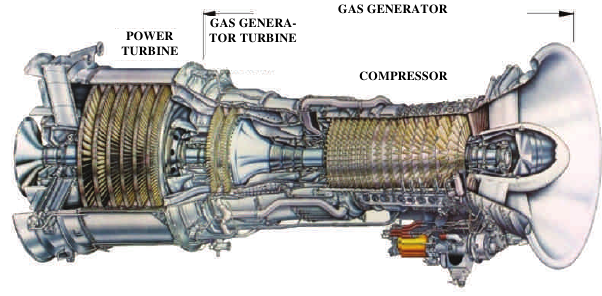
Fig. 4. LM 2500 marine gas turbine